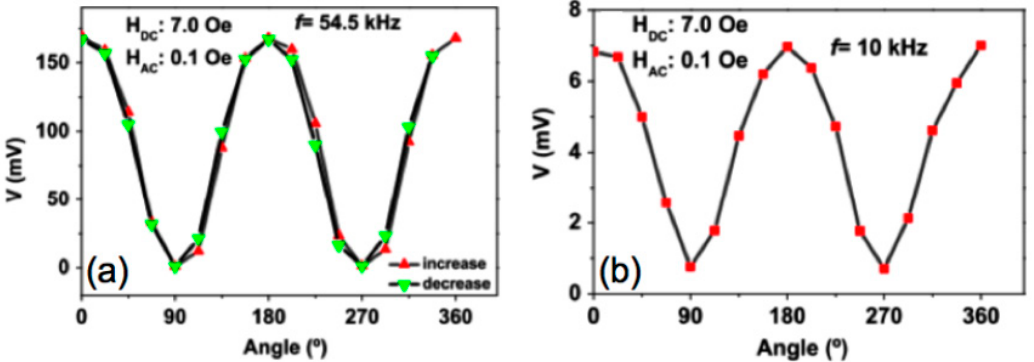
Figure 3. ME voltage value variation with the 0°–360° angle range at: ( a ) resonance frequency and ( b ) non-resonance frequency. Figure taken with permission from [20].